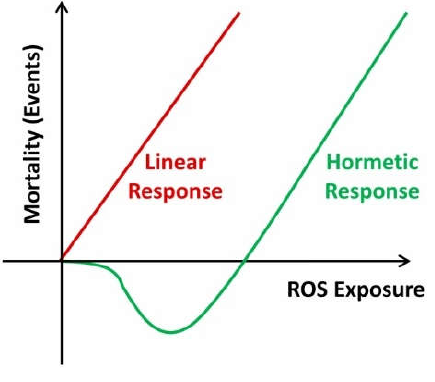
Figure 9. Hormetic response.